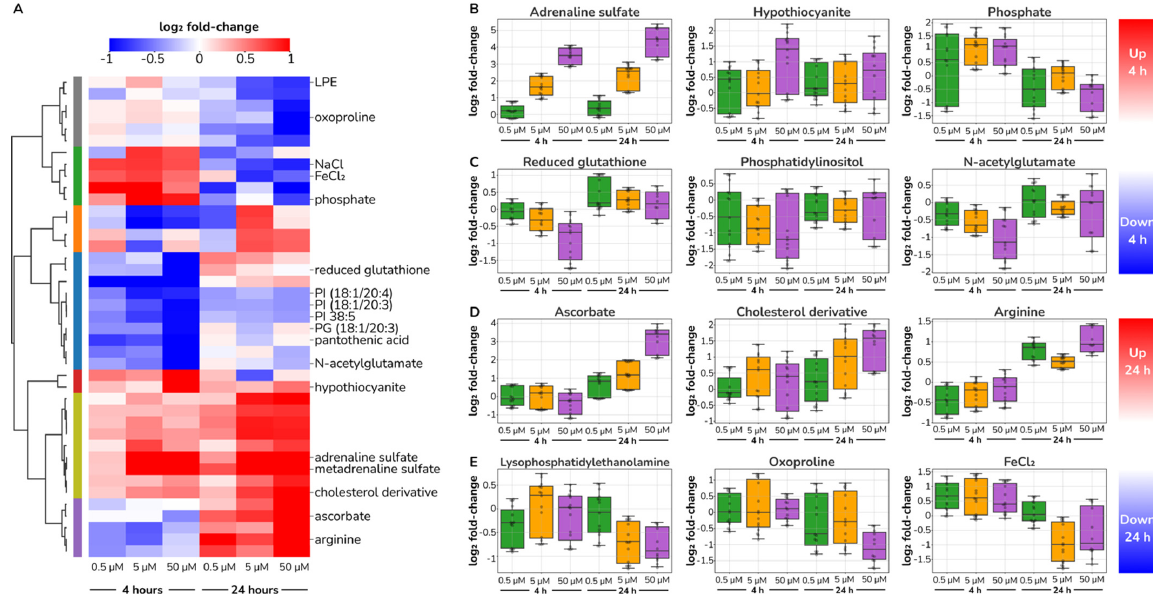
Figure 4. Catecholamine stimulation alters the glutathione-ascorbate cycle and the nitric oxide biosynthesis pathway. ( A ) Heatmap of the relative change (log 2 fold change with respect to unstim- ulated cells) of the set of 46 dose–response metabolic features. Across time and catecholamine con- centration (columns), metabolic features (rows) form seven clusters highlighted by a colour bar and dendrogram tree on the left. PI, phosphatidylinositol; PG, phosphatidylglycerol. ( B – E ) Measured metabolite fold-change intensity with respect to unstimulated cells at 4 and 24 h for different cate- cholamine concentrations.